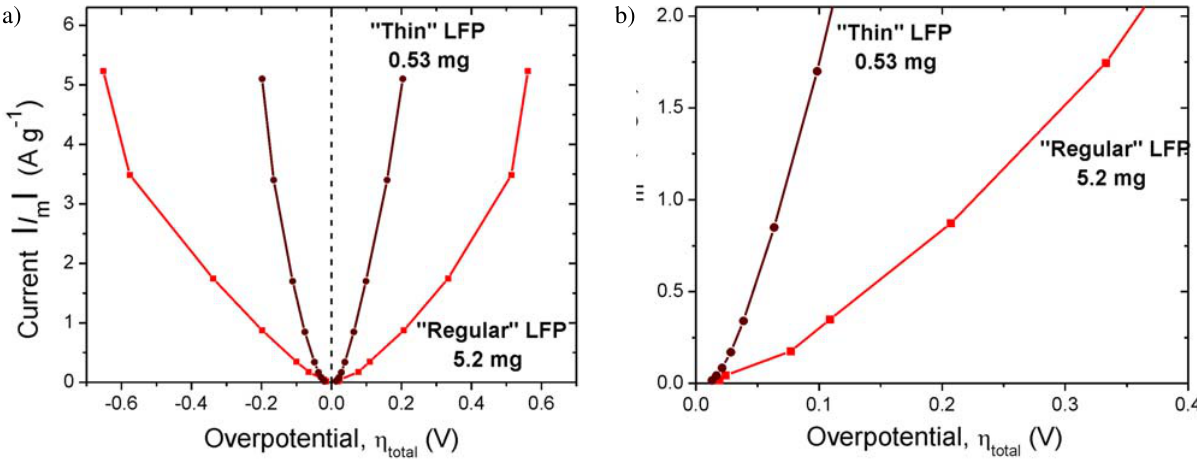
Figure 5. Absolute current-Overpotential ( I – η ) characteristics of the LFP electrode with “regular” thickness (5.2 mg, red, the same as in Fig. m total 4 ) and “thin” LFP electrode (0.53 mg, orange) obtained using the inflection point criterion together with Eq. 3. Data in panel (b) are merely a mag- nification of those in panel (a) for low and medium positive current values. The data for LFP with “regular” thickness was extracted from the set of galvanostatic curves shown in Fig. 1b , while for the “thin” LFP electrode from Fig. S1